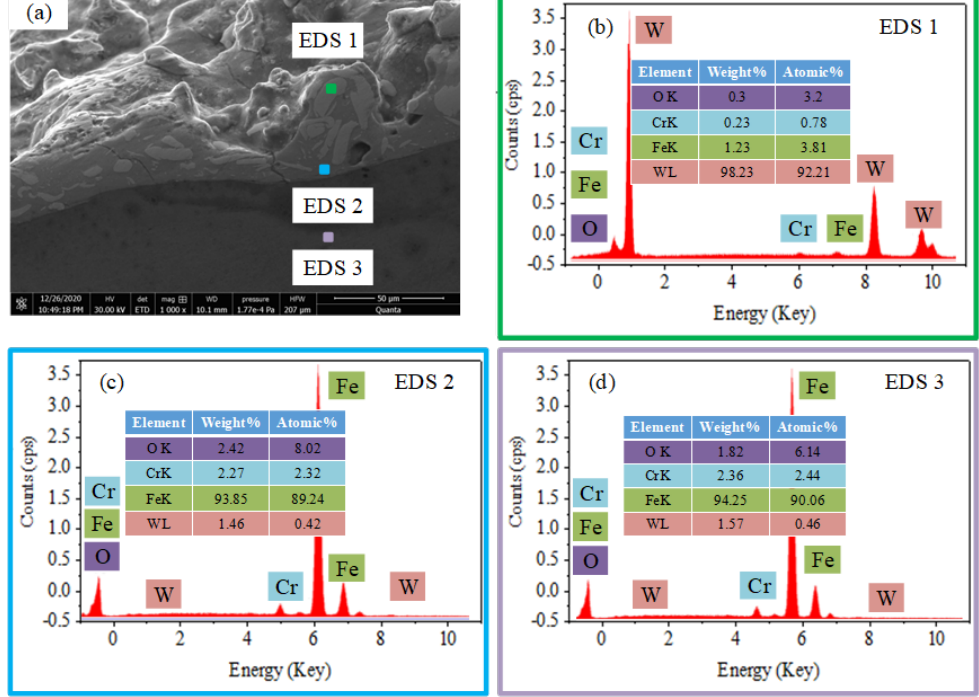
Figure 6. Section morphology and EDS spectra of the crater. ( a ) Region I of the 93W crater, ( b ) EDS 1, ( c ) EDS 2, and ( d ) EDS 3.